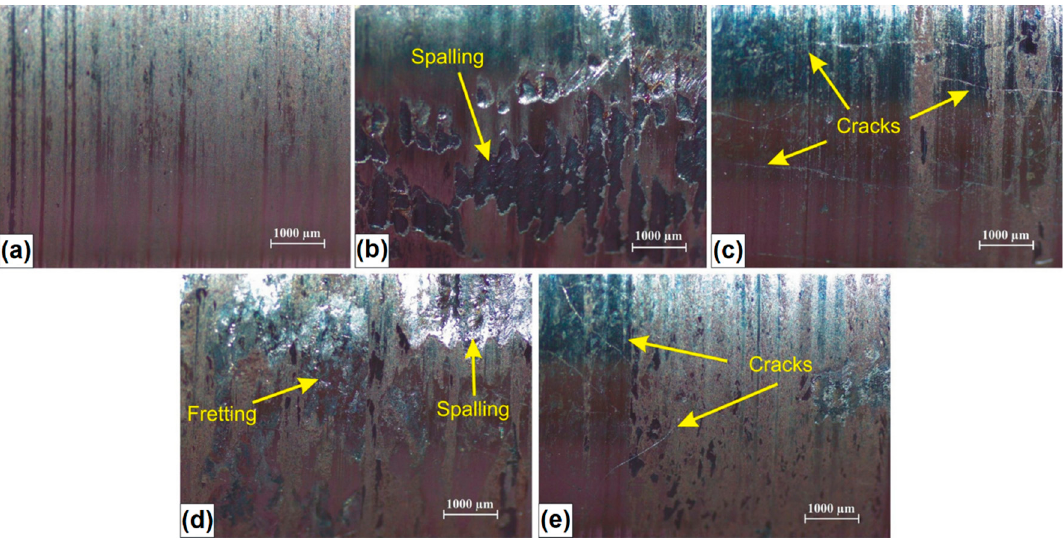
Figure 11. Surface condition of studied specimens after wear resistance test: ( a ) C45 steel; ( b ) Si